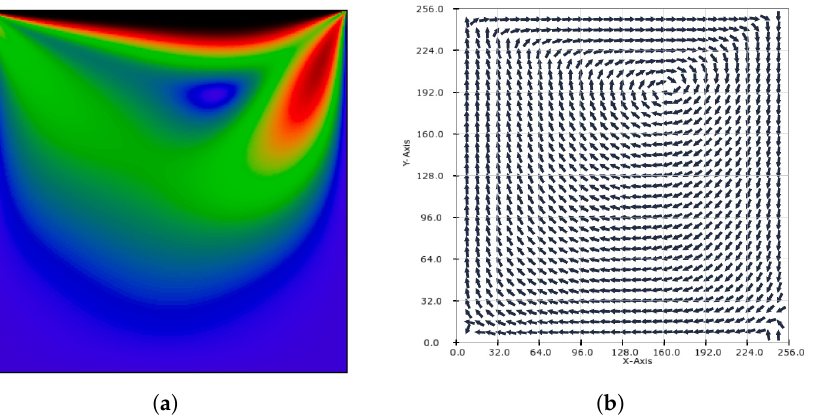
Figure 3. Lid-driven cavity test case at 128 × 128 resolution after 5000 iterations. ( a ) Visualization of lid-driven cavity simulation; ( b ) Velocity vector field.